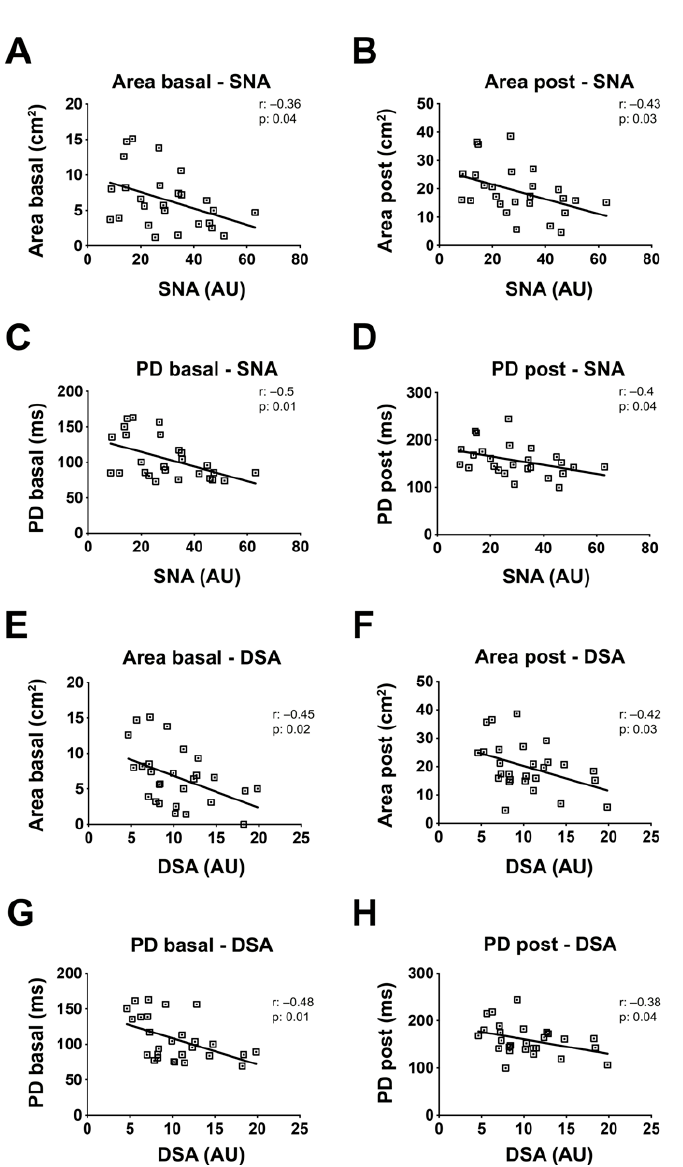
Figure 6. Membrane protein sialylation levels of PBMCs correlate with BrS clinical features. The correlation between sialylation with clinical features was analyzed by comparing the PBMCs proteins membrane SNA and DSA levels with different clinical parameters of BrS patients. Correlation between SNA levels and basal ( A ) and post-ajmaline ( B ) pathological substrate area, and basal ( C ) and post-ajmaline ( D ) PD. Correlation between DSA and basal ( E ) and post-ajmaline ( F ) pathological substrate area, and basal ( G ) and post-ajmaline ( H ) PD. BrS: N = 16. Each square in the graphs represent a single BrS patient. The statistical significance of the correlation was evaluated using the Pearson’s r coefficient and the p value.